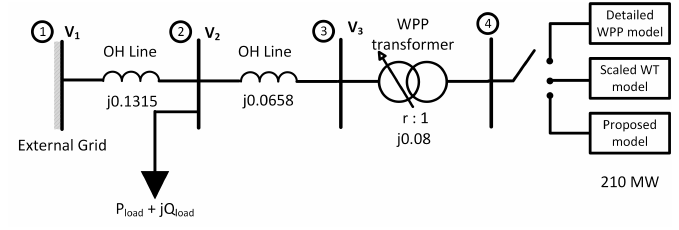
Figure 13. Simple power system